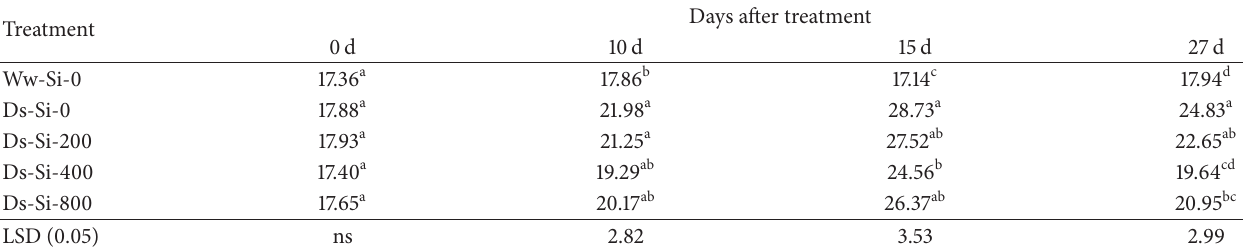
Table 1: Influence of silicon application on C: N ratio of Kentucky bluegrass leaves under drought stress.